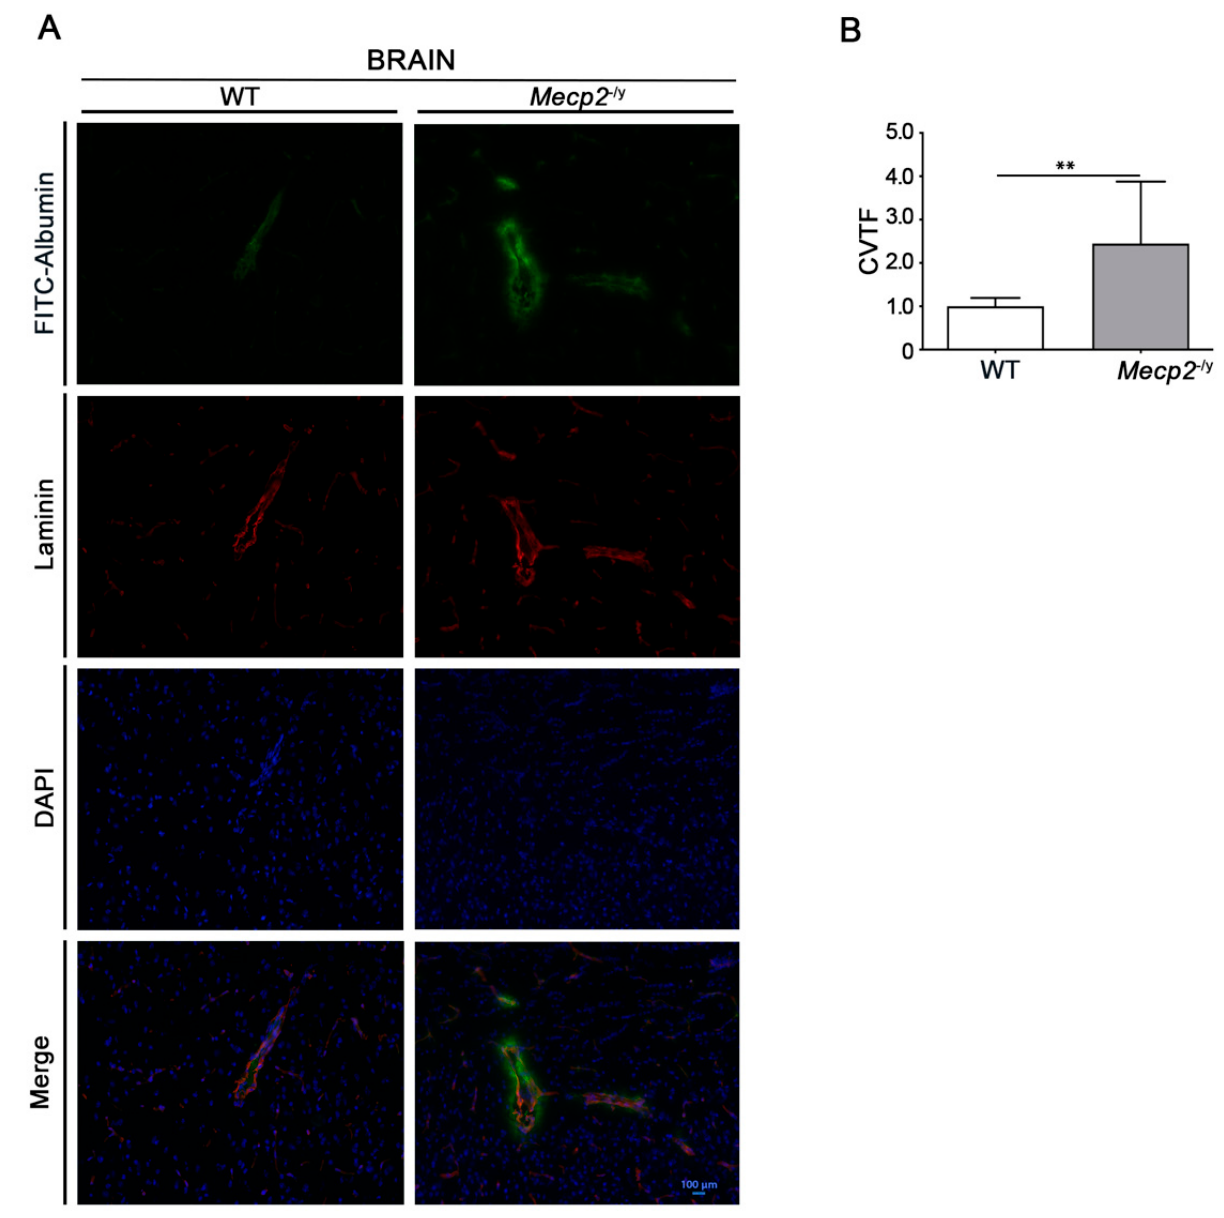
Figure 1. BBB disruption in Mecp2 -/y mouse model. Representative fluorescence micrographs ( A ) of brain cryosections from symptomatic Mecp2 -/y mice and age-matched WT littermates; semi-quantitative analysis ( B ) of FITC-albumin extravasation (bright green fluorescence) normalized on vessel marker laminin (red). Data are represented as mean ± SD from eight coronal sections from two different mice. **, p < 0.01; (Mann–Whitney test). CTVF—corrected total vessel